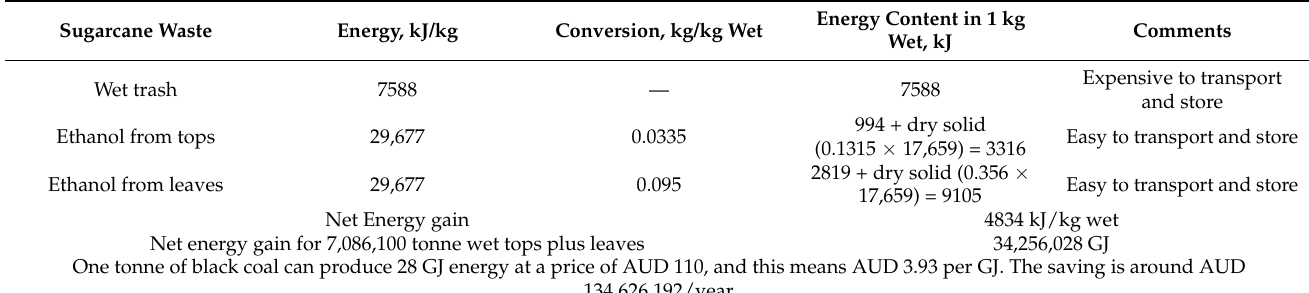
Table 15. Energy production from wet trash compared to